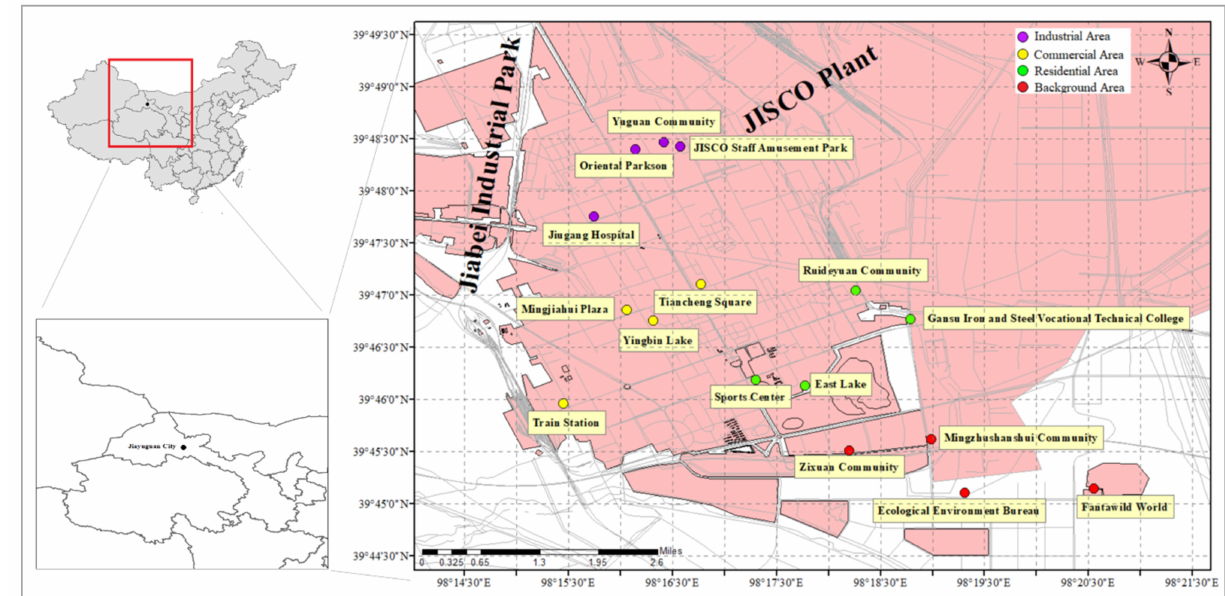
Figure 1. Distribution of sampling